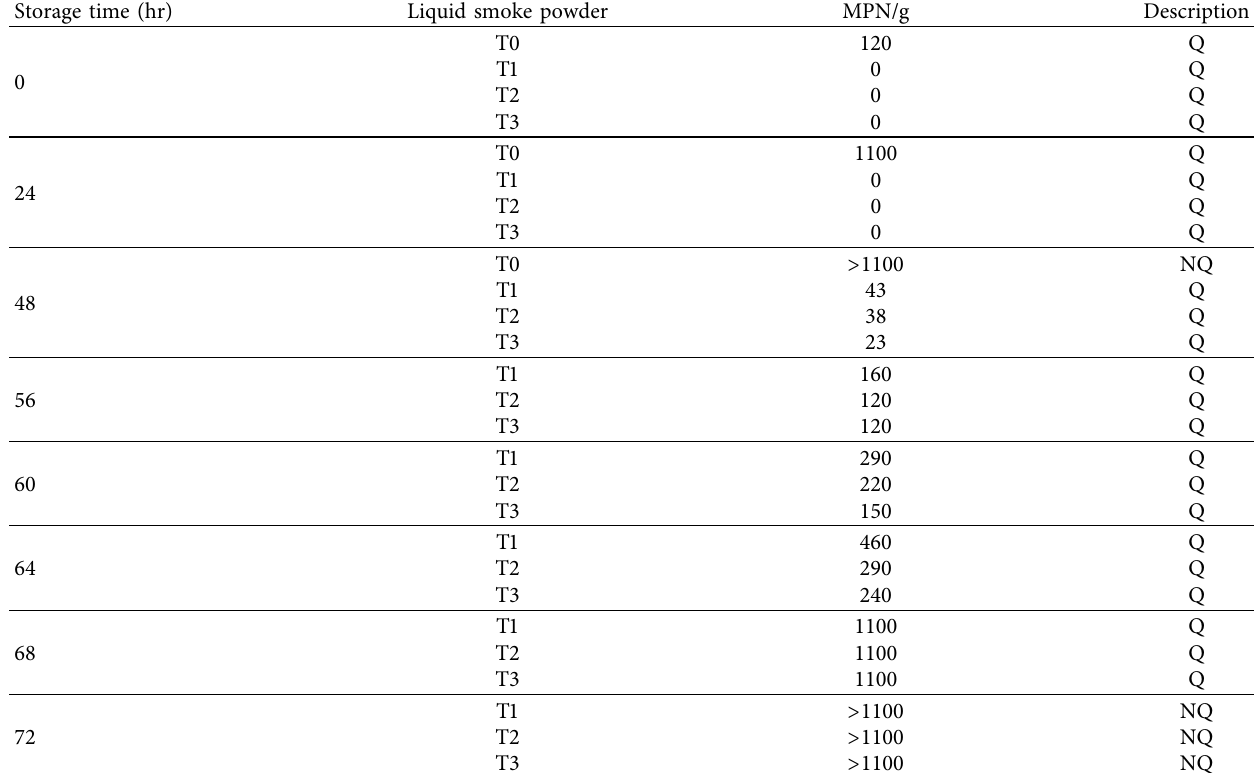
Table 1: Test results for MPN E. coli